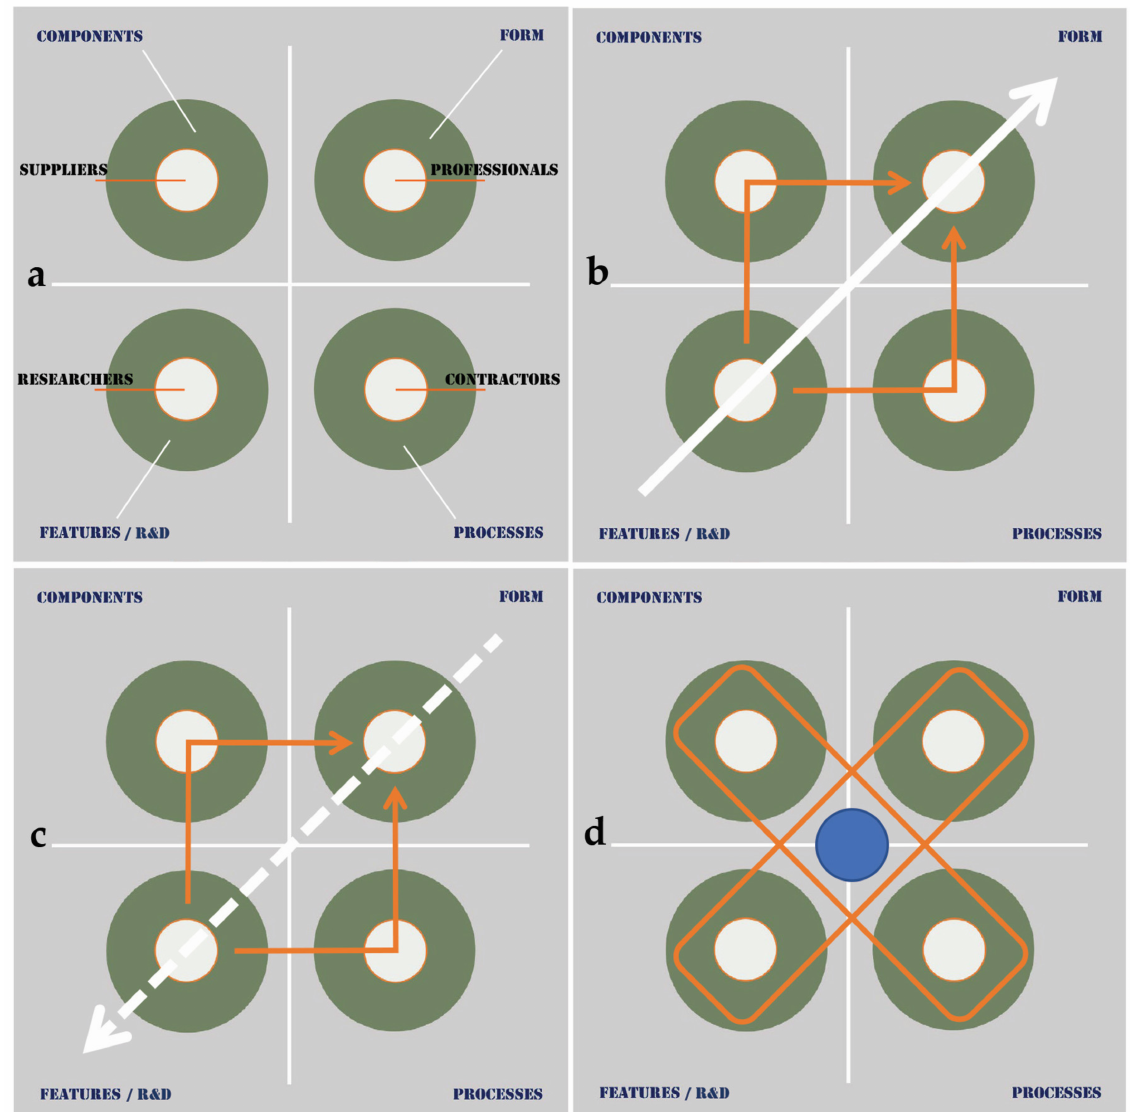
Figure 15. The four social-technical components of building industry with innovation axes of iconic buildings (infographics produced for AR-487 Technological Innovation, Lecture 4, EPFL, auth. Tombesi, 2019). ( a ) In the upper left corner is the contribution of manufacturing and the activities of suppliers; the lower left end corner designates R&D-derived modifications to existing product; the lower right end corner indicates building procurement methods and the activities of contractors; and the upper right system standing for form describes the activities of building professionals. ( b ) The axis shows the pulling direction of technical changes in case of “iconic” building projects, where form is the determining factor in the process leading to the modification of material solutions. ( c ) The need to invert the direction of the pull from “form” to “features” to prevent the lack of appropriate operational and discursive links between the elements in the pulling axis and the “construction processes” and “components”. ( d ) The idea of “project design” in non-standard buildings